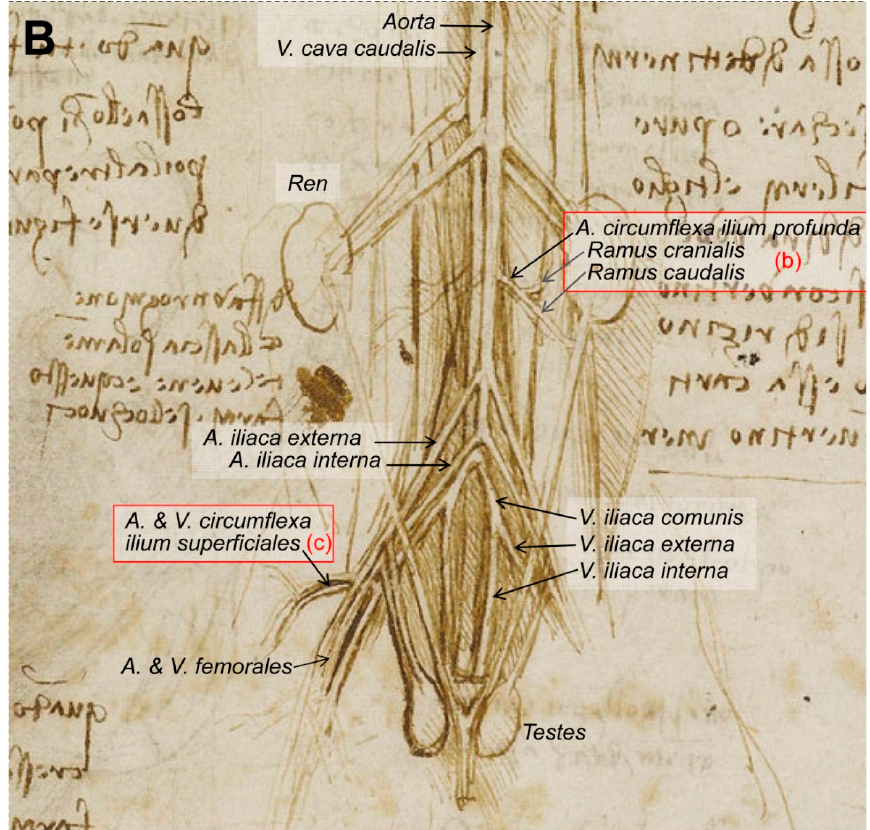
Figure 6. The viscera of a horse? ( A ) Whole drawing representing the ventral aspect of the trunk of an animal with the canalis alimentarius and lungs removed. ( B ) Inset at higher magnification depicting the lumbar and pelvic regions. The viscera of a horse c.1490–1492. Modified from www.rct.uk/collection/919097 recto (Royal Collection Trust [3]). This image is credited as Royal Collection Trust / © Her